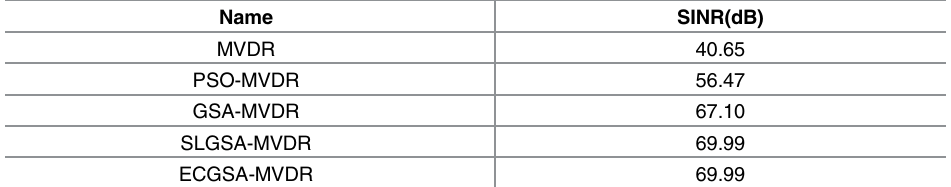
Table 9. Comparison of SINR calculation for conventional MVDR, PSO-MVDR, GSA-MVDR, SLGSA-MVDR [28] and ECGSA-MVDR for user at 0° and interference at 30°.